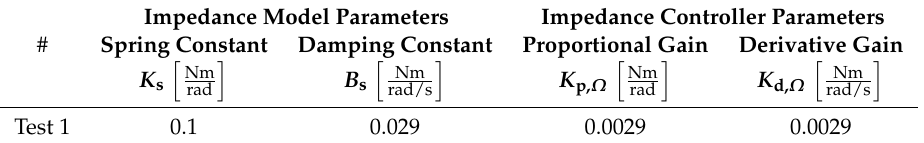
Table A3. Impedance model and controller